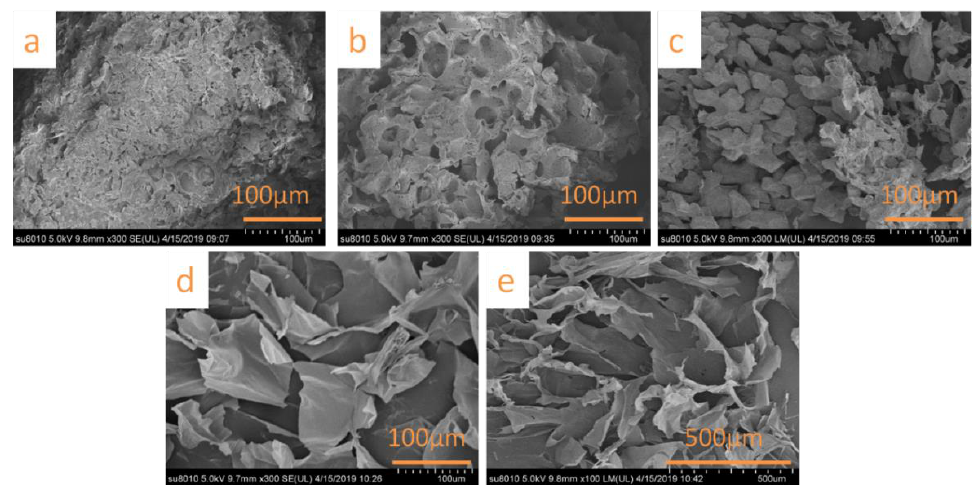
Figure 2. SEM micrographs of ( a ) WS, ( b ) N-WS, ( c ) B-WS, ( d ) nanocellulose obtained via